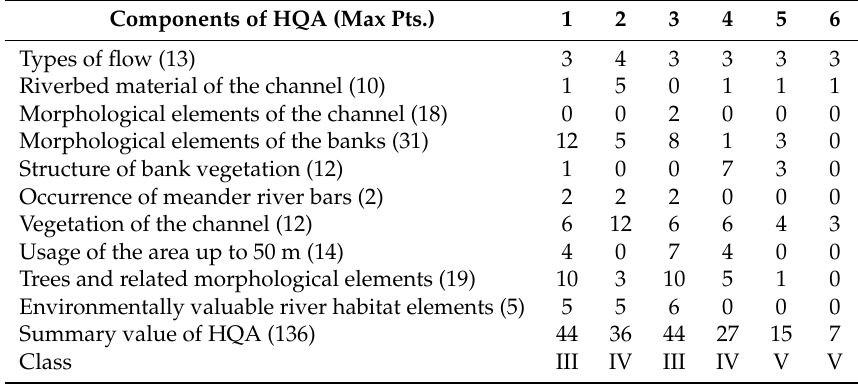
Table 6. Component and average values of the habitat natural state index (HQA) above and below the hydropower plants on the rivers Bystrzyca, ´Sl˛eza, and Odra.